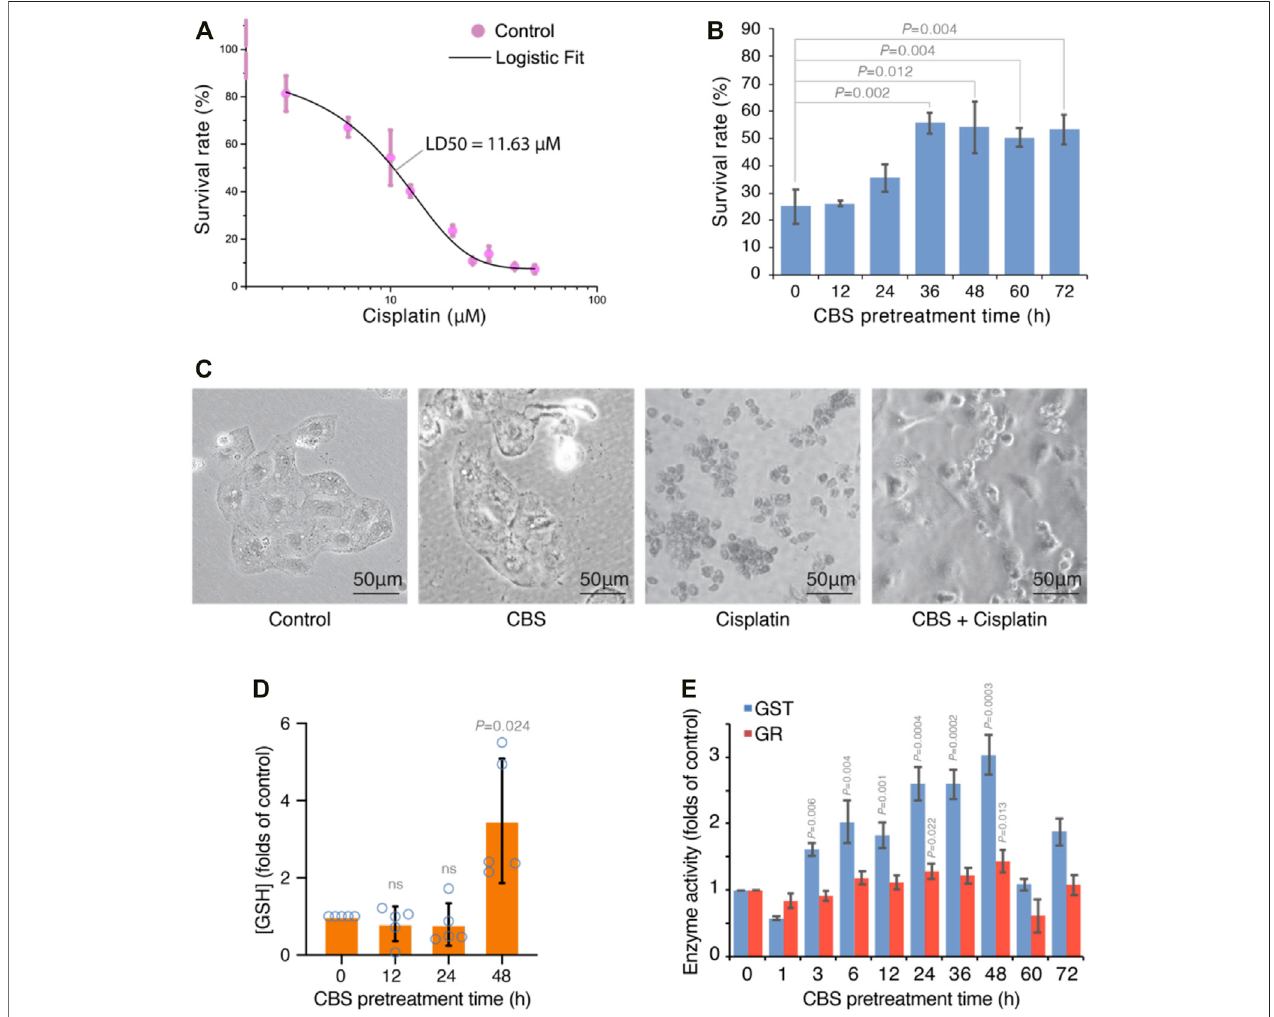
FIGURE 4 | Bismuth synchronously mitigates cisplatin-induced cytotoxicity and enhances glutathione metabolism in HK-2 cells. (A) Dose-response curve of cisplatin-inducedtoxicityinHK-2cells.Thecellsweretreatedwithdifferentconcentrationsofcisplatinfor24 h,andtheLD50isdeterminedtobe11.63 µMbyLogistic fi t. (B) CBSpretreatment mitigatescisplatin-inducedcytotoxicityinHK-2 cells.Thecellswerepretreated with500 μ MCBSfordifferentperiods oftime beforebeing treated with20 μ Mcisplatinfor24 h. (C) Bright- fi eldimagingofHK-2cellsundercontrol,cisplatintreatment(20 μ Mfor24 h),andCBSpretreatment(500 μ Mfor48 h)plus cisplatin treatment (20 μ M for 24 h). (D) Bismuth increased the GSH level in HK-2 cells. The cells were treated with 500 μ M CBS for 12, 24, and 48 h. (E) Bismuth increases GST and GR activities in HK-2 cells. The cells were treated with 500 μ M CBS for different periods of time. Bismuth enhances GSH-mediated vesicular sequestration of